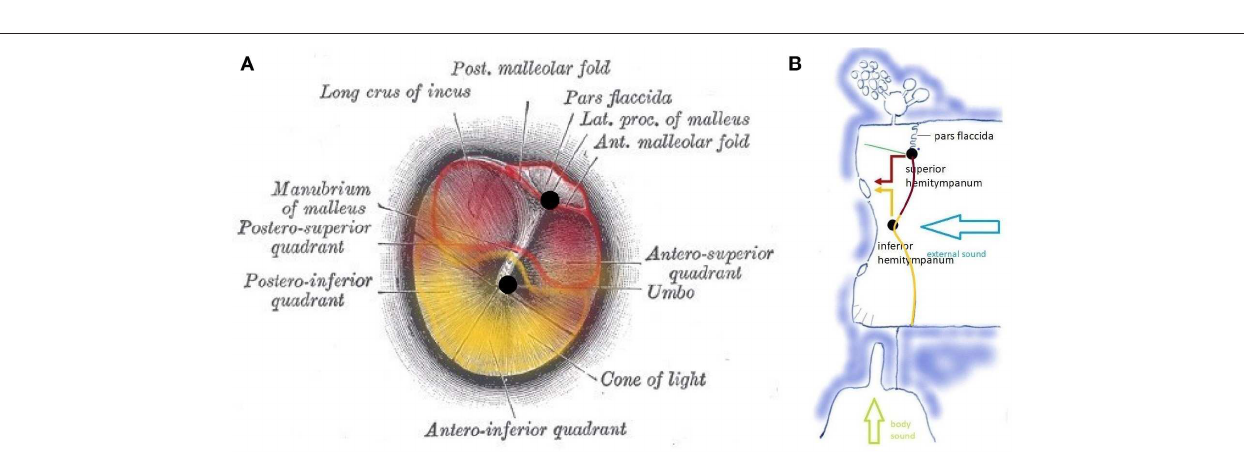
Frontiers in Neurology |